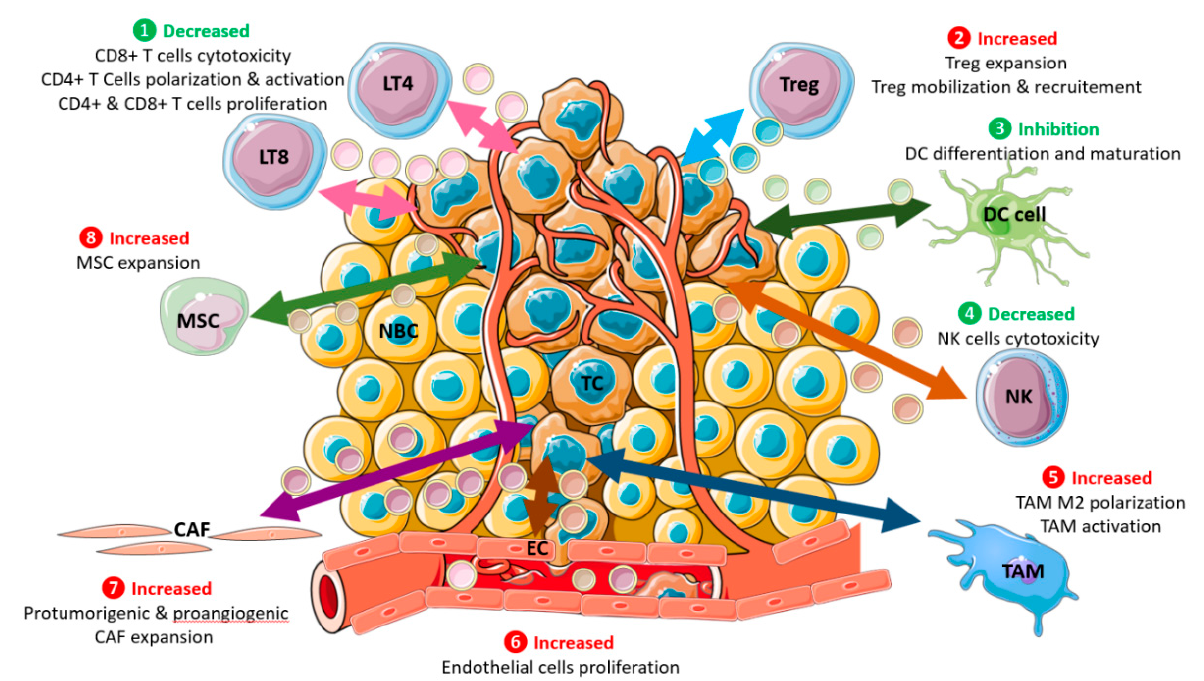
Figure 3. Bidirectional communication between tumor cells and their surrounding environment. The tumor microenvironment (TME) is a complex and dynamic network that includes normal breast (NBC), tumor (TC), cancer-associated fibroblasts (CAFs), mesenchymal stromal (MSC), immune (tumor-associated macrophages TAM), and endothelial cells (EC). TC can bidirectionally signal to each other through SEVs production. TC can produce SEVs that will regulate MSCs’, CAFs’, and TAMs’ differentiation and activity. MSCs as well as TCs can regulate ECs’ activity, especially in hypoxic situations. TAMs, CAFs, and ECs can cooperate to promote angiogenesis. An antitumor immune response is largely modulated by BC cells through either extracellular signaling molecules (cytokines, etc.) secretion or SEVs production and release. BC cells SEVs contain inhibiting or activating molecules that favor target cells expansion, mobilization, and recruitment (CD4+ T cells (LT4), Tregs, and MSCs), polarization and activation (tumor-associated macrophages TAMs M2), and block others (CD8+ T cells (LT8), dendritic cells (DC), and natural killer NK cells).